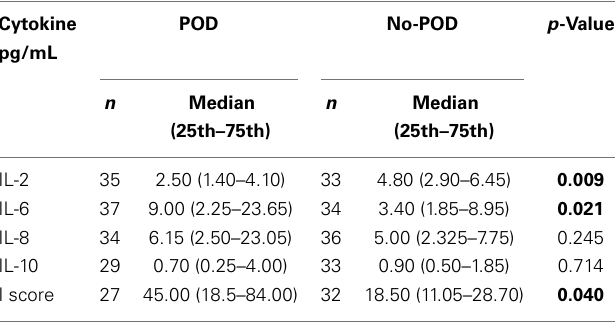
Table 2 | Plasma cytokines in patients with post-operative delirium (POD) vs. patients with no-POD